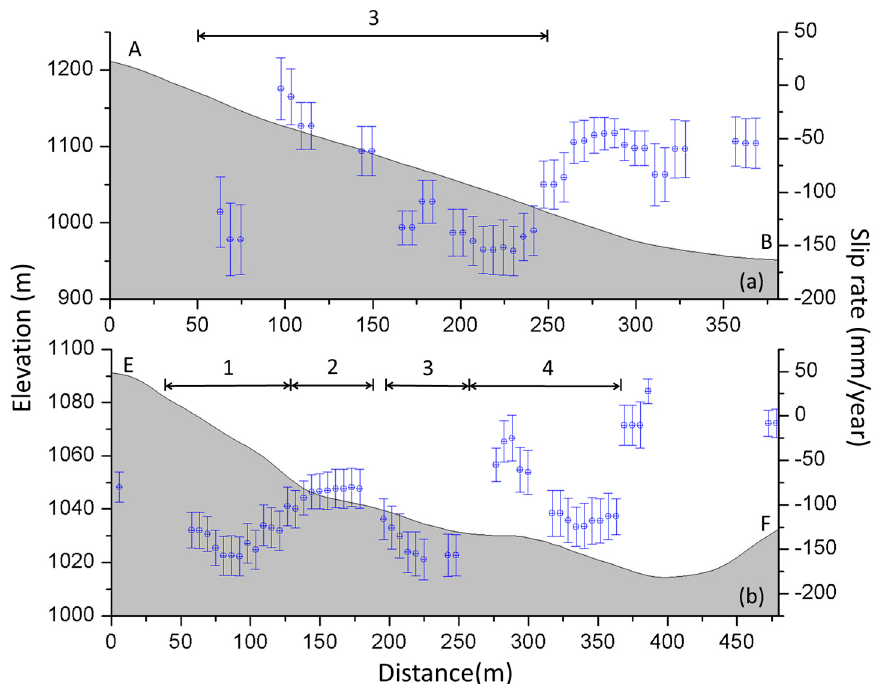
Figure 7. Average pre-slide slip rate in the downslope direction and elevation along ( a ) profile AB and ( b ) profile EF denoted in Figure 6. Error bars represent the standard deviations of the estimated mean velocity. The extent of the creep bodies is marked at the top of each figure.